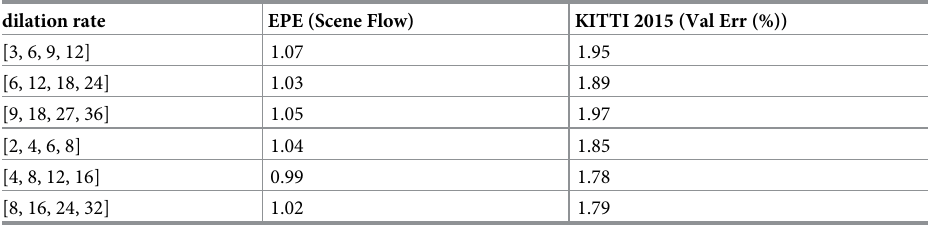
Table 2. The experiment of ASPP structure on Scene Flow.